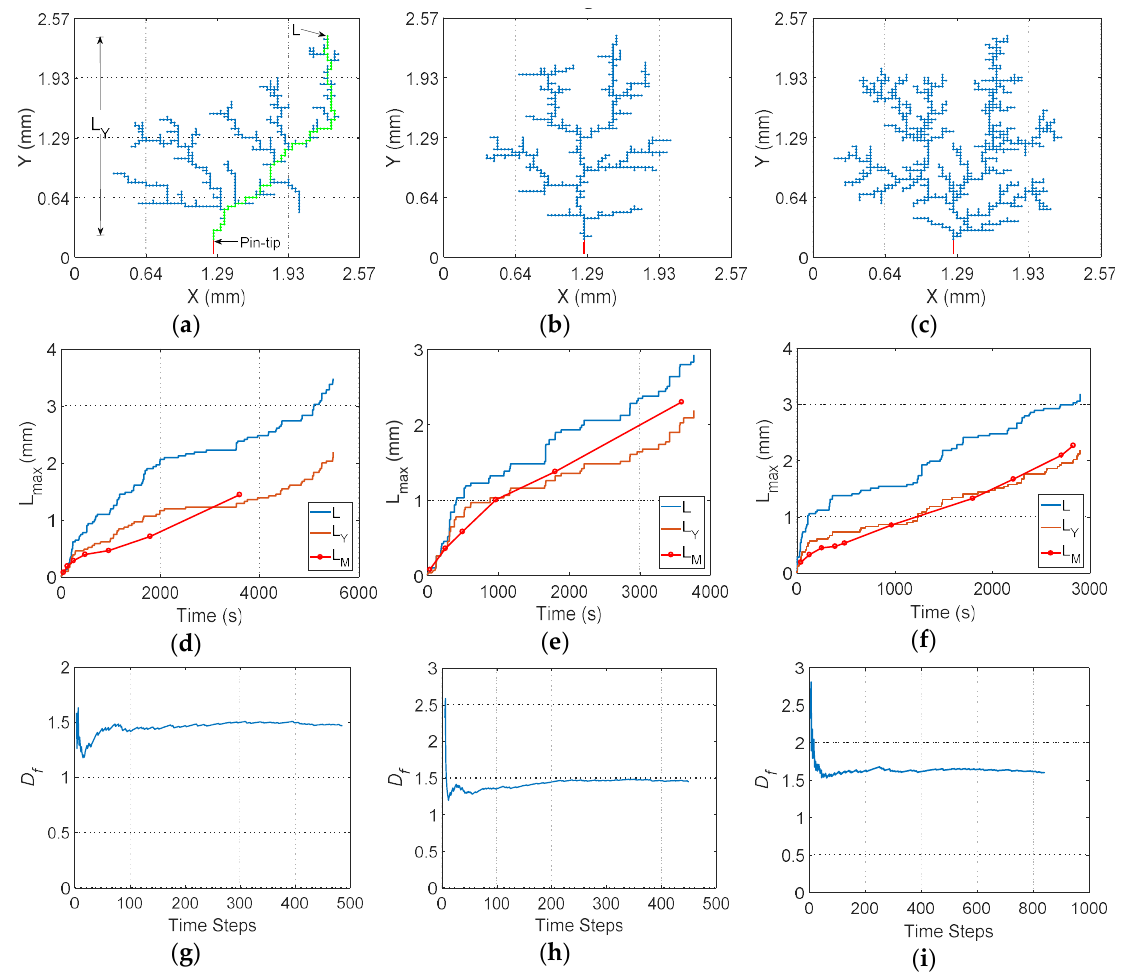
Figure 3. Typical simulation results for the case study. From the top to the bottom: ( a – c ) tree structure in 2D; ( d – f ) evolution in time of the maximum simulated length (L), the maximum simulated length on the Y axis (L Y ), and the measured length on the Y axis (L M ); ( g – i ) the calculated fractal dimension. From the left to the right, applied voltage: 7, 10 and 15 kV.